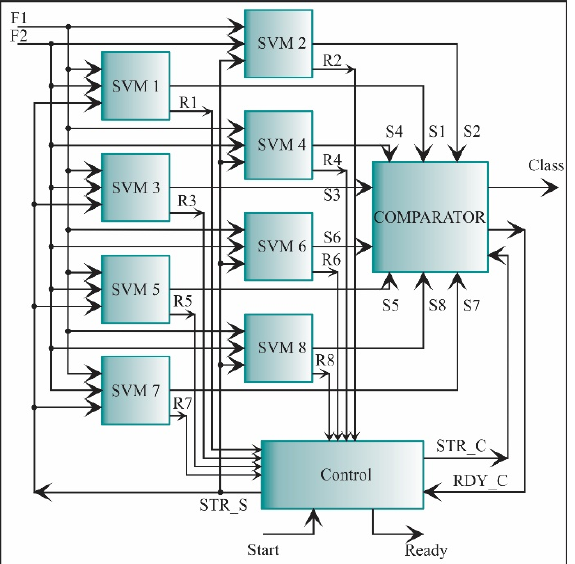
Figure 23. The architecture of the processing core for one-against-all SVM classification.